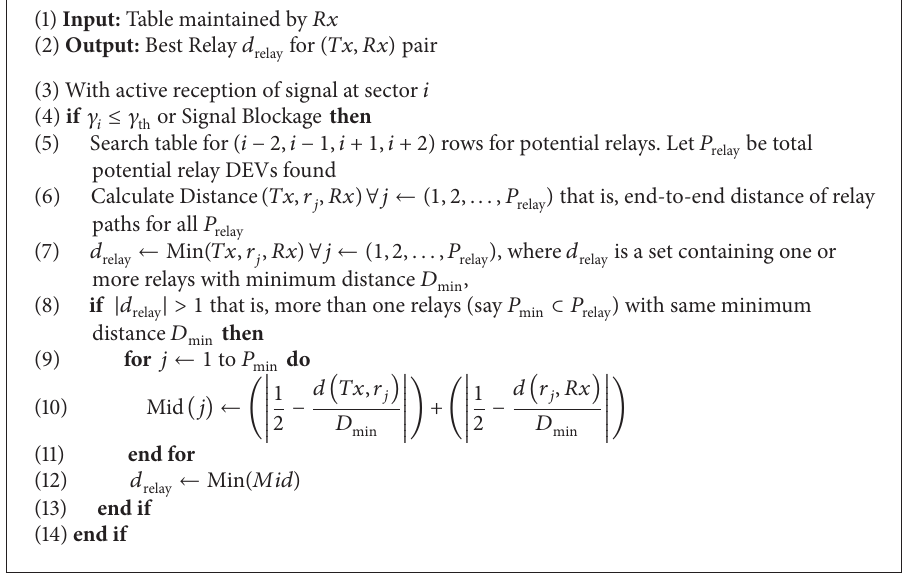
Search table for (𝑖 − 2,𝑖 − 1, 𝑖 + 1, 𝑖 + 2) rows for potential relays. Let 𝑃